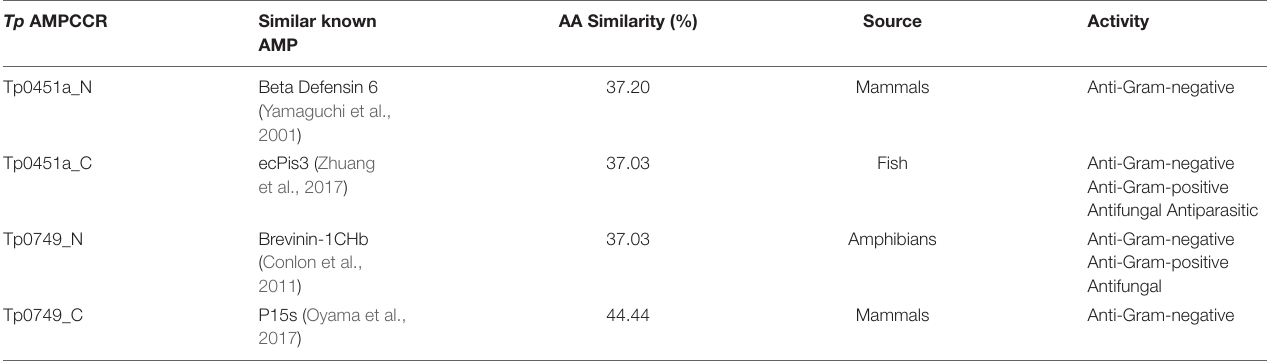
TABLE 2 | Known AMPs with the highest similarity to four T. pallidum candidate AMPCCRs.